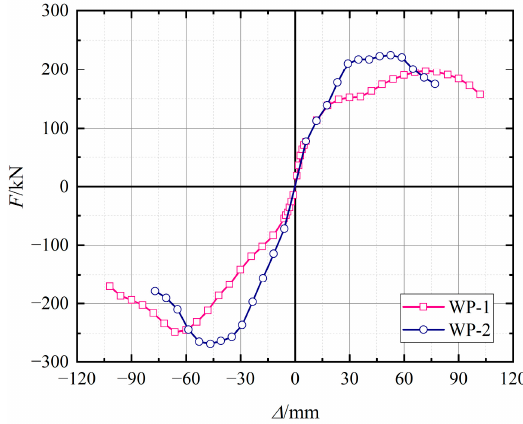
Figure 11. The skeleton curves of WP-1 and WP-2.